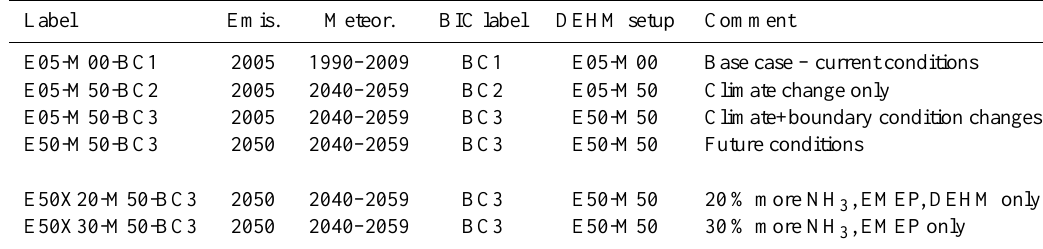
Table 1. Model runs used in this study. Label Emis. Meteor.